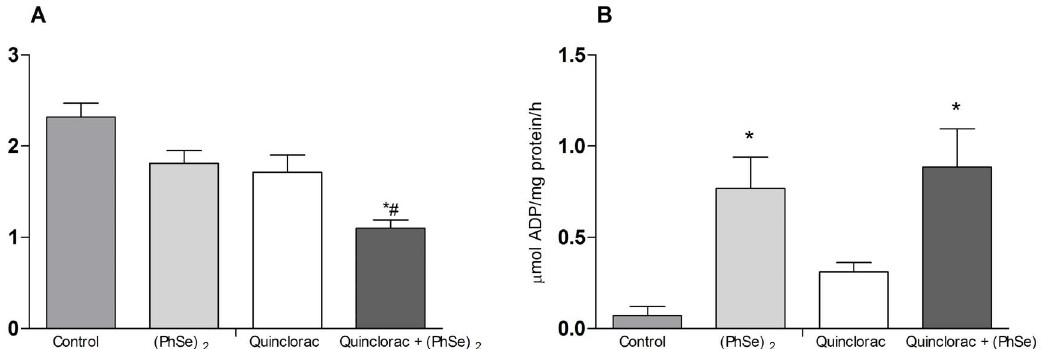
Figure 3. Gill ATPase activities. Na + /K + -ATPase (A) and H + -ATPase (B) activities in gills of silver catfish fed for 60 days with diets containing 0 or 3.0 mg/ Kg of (PhSe) 2 and after exposed to quinclorac herbicide or to control conditions. Data are reported as mean ¡ SEM (n 5 12). (*) P , 0.05 as compared with the control group. ( # ) P , 0.05 as compared with the quinclorac